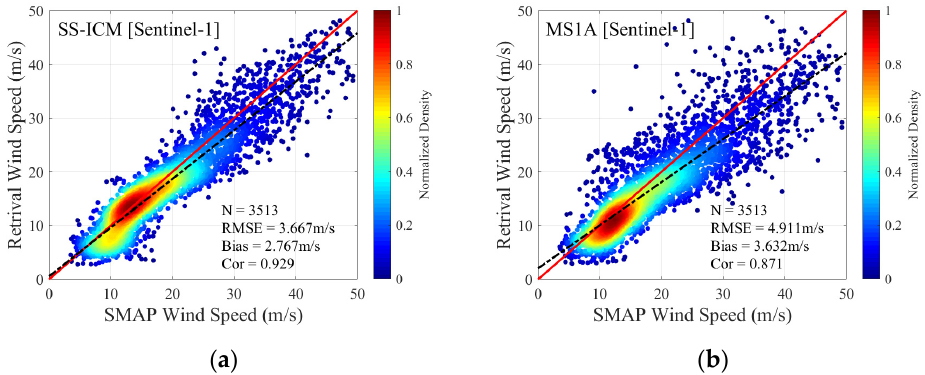
Figure 19. Comparisons of retrieved wind speeds from S-1 SAR with collocated SMAP wind speed. ( a ) SS-ICM model. ( b ) MS1A model.